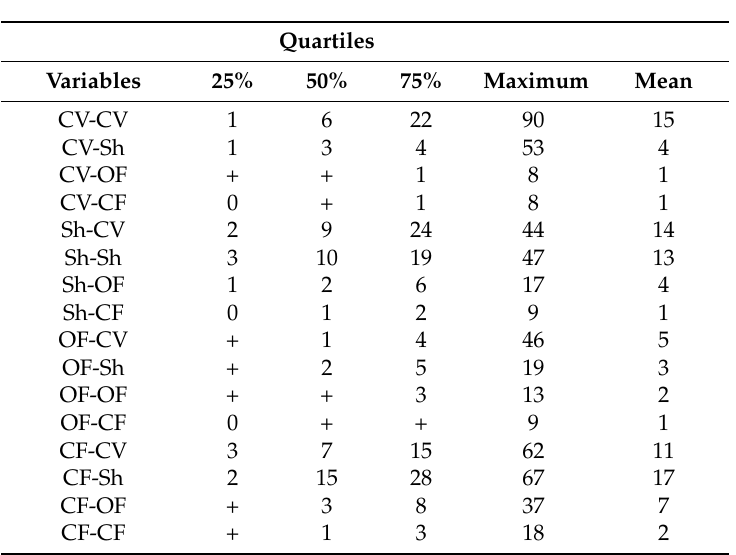
Table 1. Descriptive statistics (quartiles, maximum values and mean) 1 of the variables (proportion, expressed in%, of land cover change classes between 1979 and 2010) for the 81 circular samples. The first two letters indicate the land cover in 1979 and the second pair indicates the land cover in 2010. Cultural vegetation (CV), Closed forest (CF), Open forest (OF), and Shrubland (Sh). Non-zero values lower than 0.5% were indicated by a